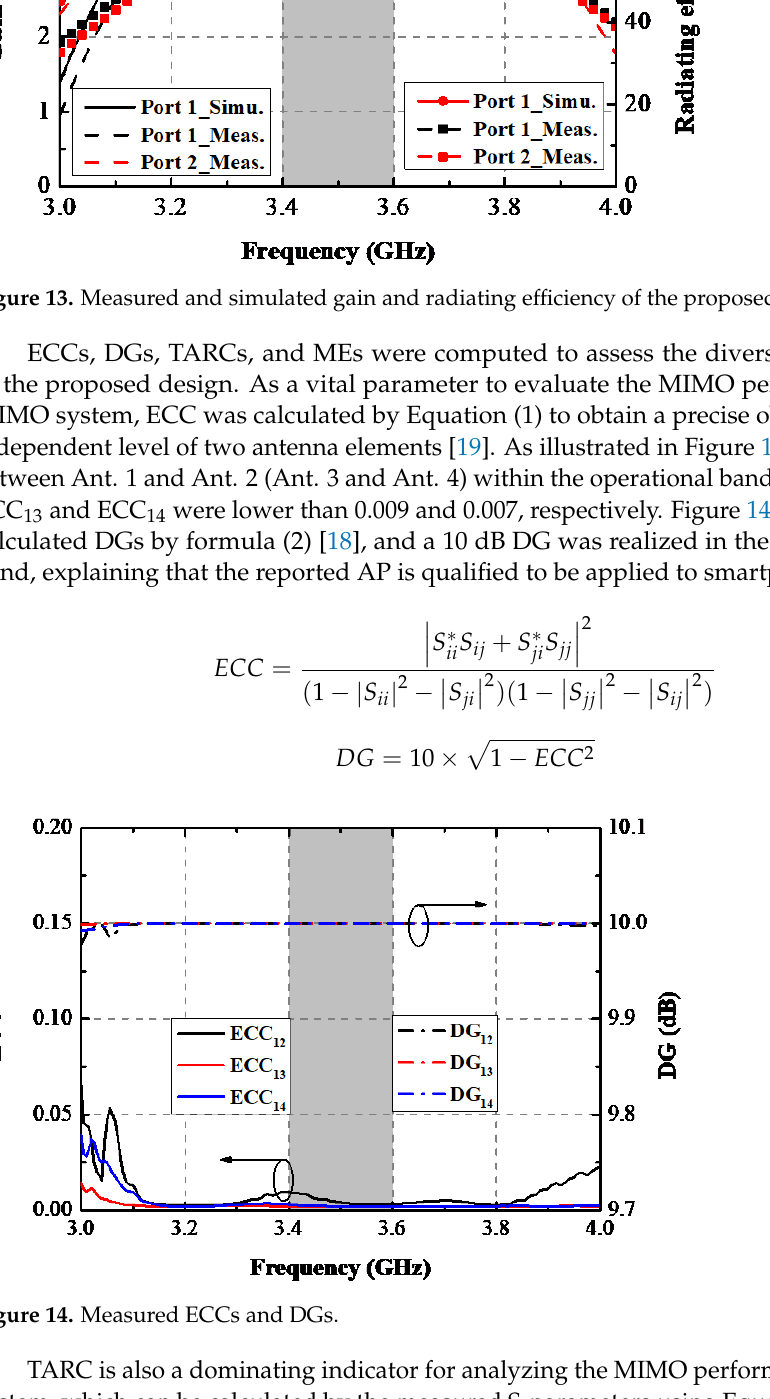
Figure 14. Measured ECCs and DGs.